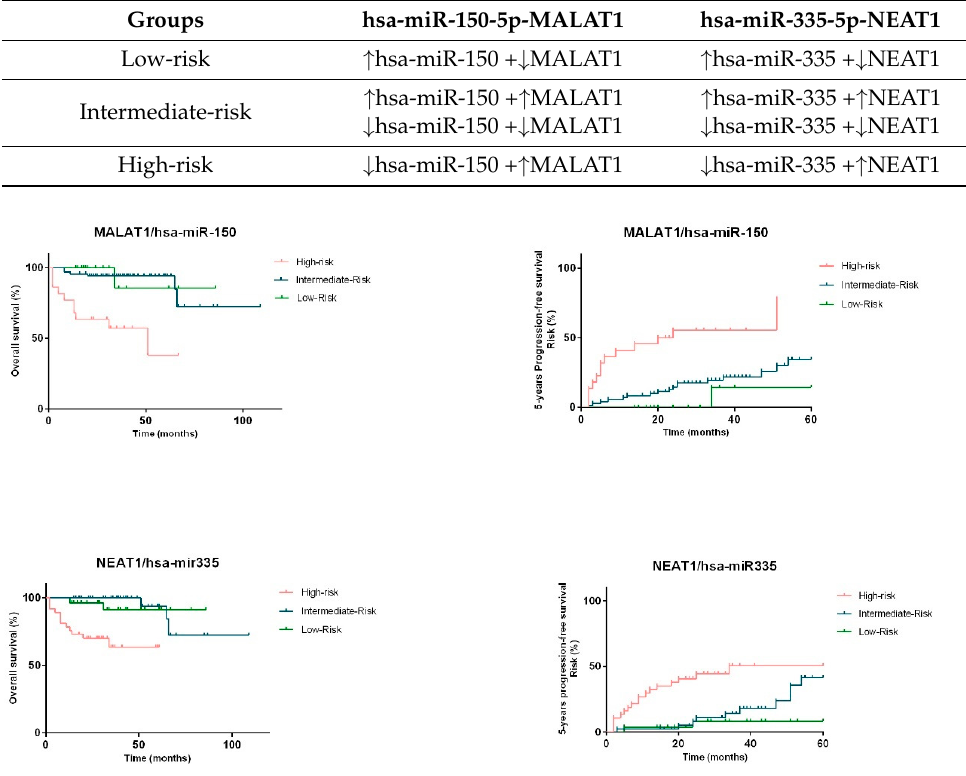
Table 1. Definition of high-, intermediate- and low-risk groups considering the combination of the plasma levels of each ceRNA pair, hsa-miR-150-5p/MALAT1 plasma levels and